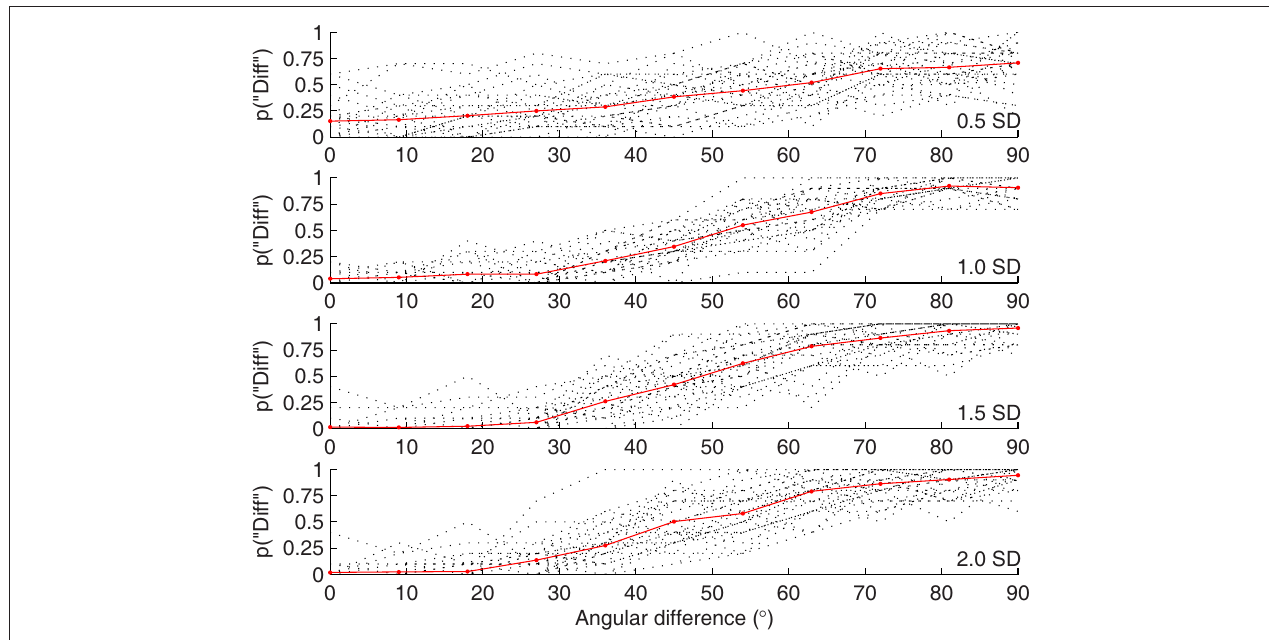
Figure 6 | Proportion “different” responses as a function of physical difference expressed as the angle subtended at the origin of face-space for the four conditions of experiment 3. Dotted lines indicate individual psychometric functions and solid red lines